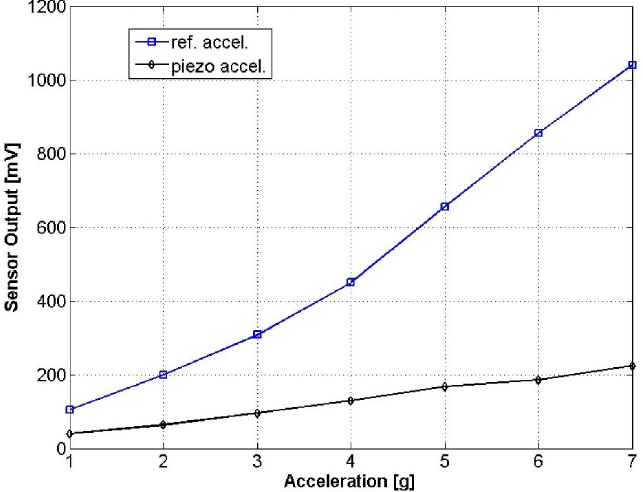
Figure 14. Sensor responses to accelerations ranging from 1 g to 7 g.